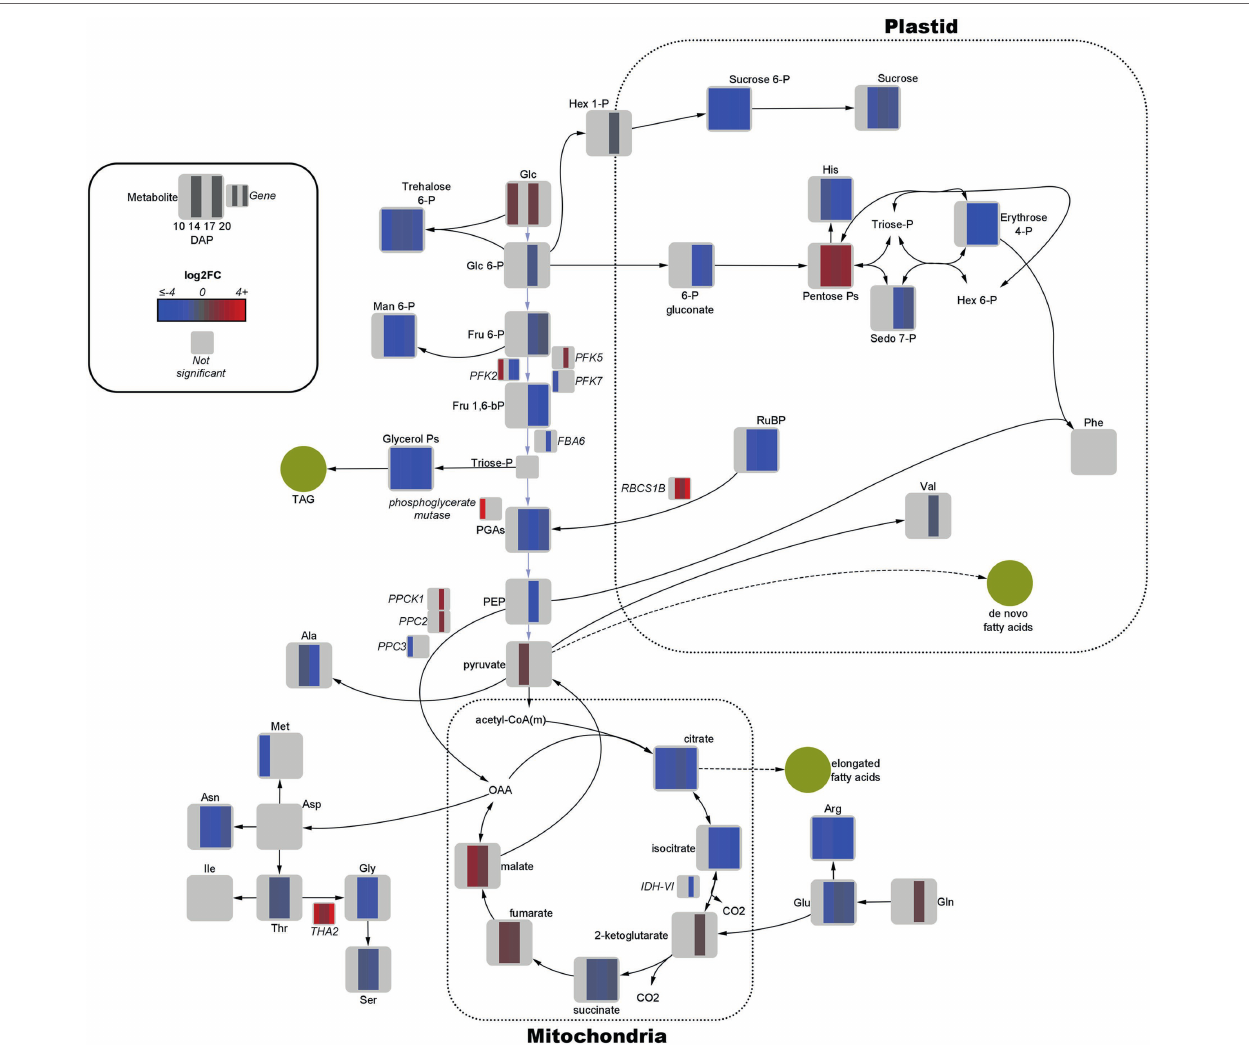
FIGURE 3 | Fold-change of differentially expressed genes and significant metabolites involved in central carbon metabolism in high oil (HO) and low oil (LO) accessions of pennycress. Data are in log 2 FC in HO with respect to LO. Solid lines indicate single reactions between nodes, whereas dotted lines indicate the presence of more than one reaction. Yellow circles indicate corresponding fatty acid or lipid pools. –bP, bisphosphate; -P, − phosphate; acetyl-CoA(m), mitochondria- localized acetyl-CoA; Ala, alanine; Arg, arginine; Asn, asparagine; Asp, aspartate; CO 2 , carbon dioxide; FBA, fructose bisphosphate aldolase; Fru, fructose; Glc, glucose; Gln, glutamine; Glu, glutamate; Gly, glycine; Hex, hexose; His, histidine; IDH = isocitrate dehydrogenase; Ile, isoleucine; Man, mannose; Met, methionine; OAA, oxaloacetate; PEP, phosphoenolpyruvate; PFK, phosphofructokinase; PGAs, phosphoglycerates (both 2- and 3-); Phe, phenylalanine; PPC, phosphoenolpyruvate carboxylase; PPCK, phosphoenolpyruvate carboxylase kinase; RBCS1B, Rubisco small subunit; RuBP, ribulose 1,5-bisphosphate; Sedo, sedoheptulose; Ser, serine; THA, threonine aldolase; Thr, threonine; Val,